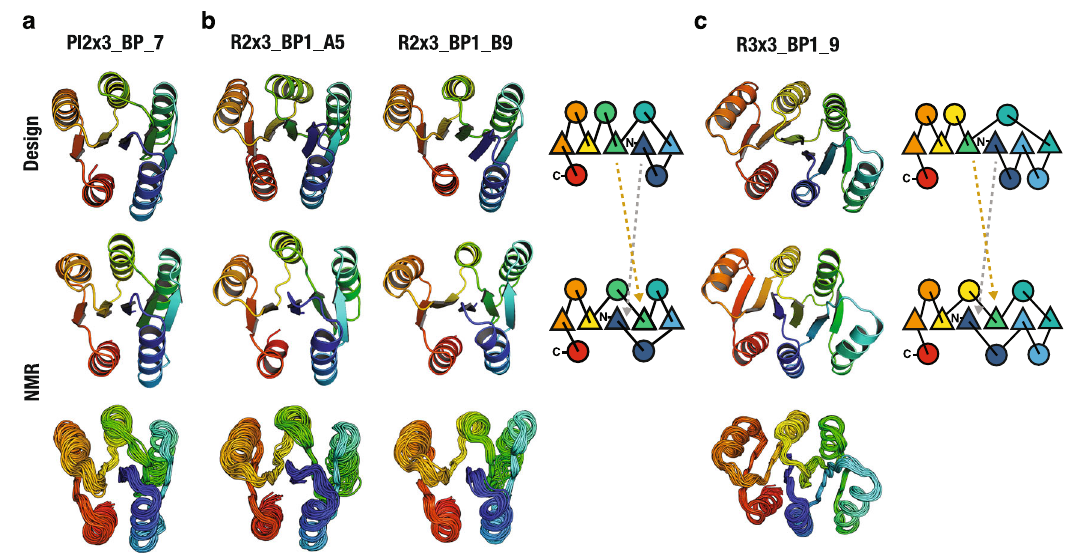
Fig. 3 NMR structure determination reveals strand swapping. Design models (upper row), together with a representative conformer (middle row) and the ensemble of conformers (lower row) determined by NMR, for a P-loop fold: Pl2×3_BP_7 (PDB: 5GAJ), b Rossmann2×3 fold: R2×3_BP1_A5 (2L69) and R2×3_BP1_B9 (2LCI), and c Rossmann3×3 fold: R3×3_BP1_9 (2L82); topology diagrams are on the right. As is clear from the topology diagrams, in the NMR structures for the Rossmann2×3- and 3×3- folds, the positions of the green and blue β -strands are swapped compared to the order in the design models.